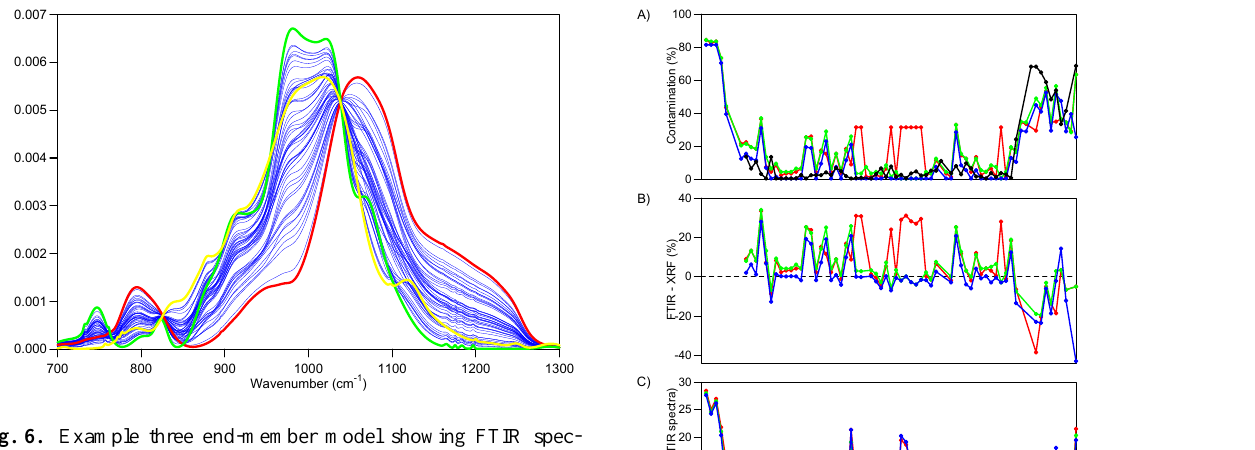
Fig. 6. Example three end-member model showing FTIR spec- tra for the Baikal diatom end-member (red line), mica (green line) and montmorillonite (yellow line). Blue lines show the ex- pected spectra for samples containing different proportions of di- atoms/contaminants. As the proportion of diatoms decreases, spec- tra are expected to progressively plot away from the pure diatom spectra and towards the mica/montmorillonite spectra. For clarity only a random 50 out of the 5151 (at 1% resolution) possible end- member spectra combinations are shown.